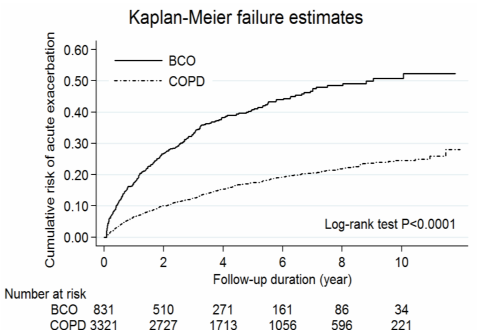
Figure 1. Kaplan-Meier curves for the cumulative risk of acute exacerbations in the patients with chronic obstructive pulmonary disease (COPD) and bronchiectasis-COPD overlap (BCO). There was a statistically significant difference between the two curves (log-rank test, p <